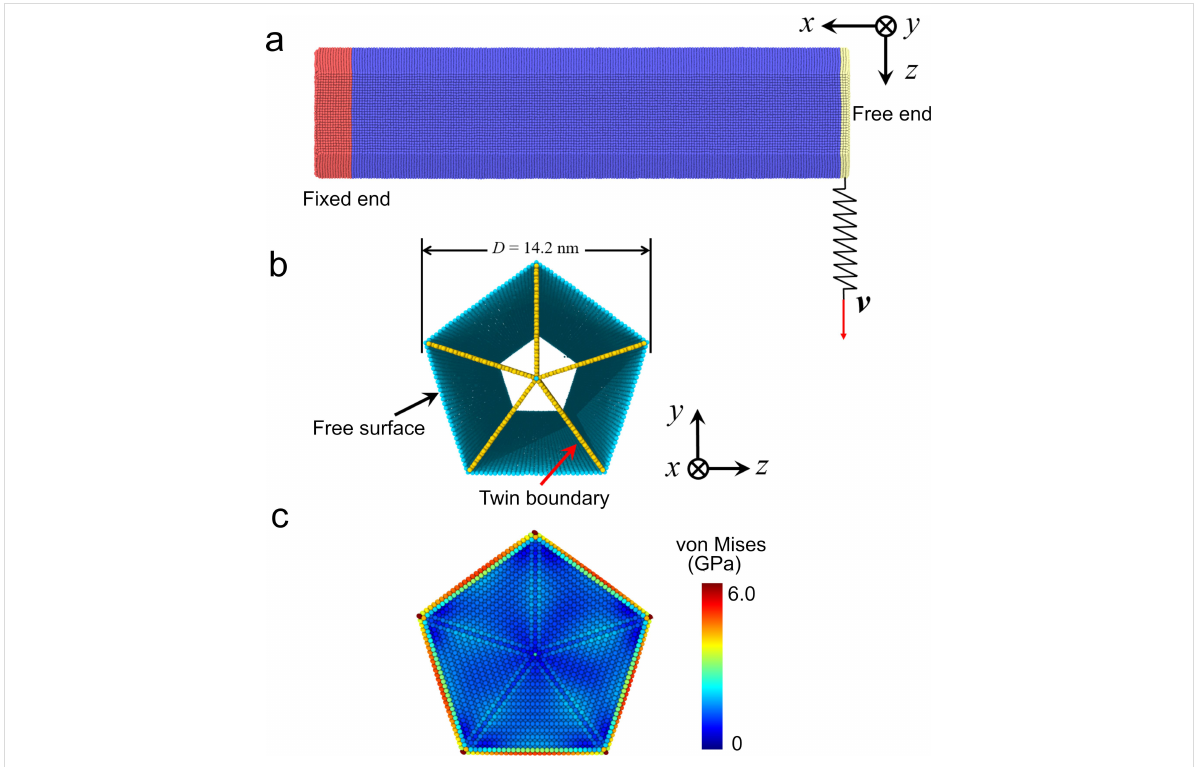
Figure 2: (a) Atomic simulation model of the Ag NW, (b) the internal twin structures (atoms in perfect lattice and those at the two ends are not shown for clarity), and (c) the distribution of von Mises stress on the cross section.